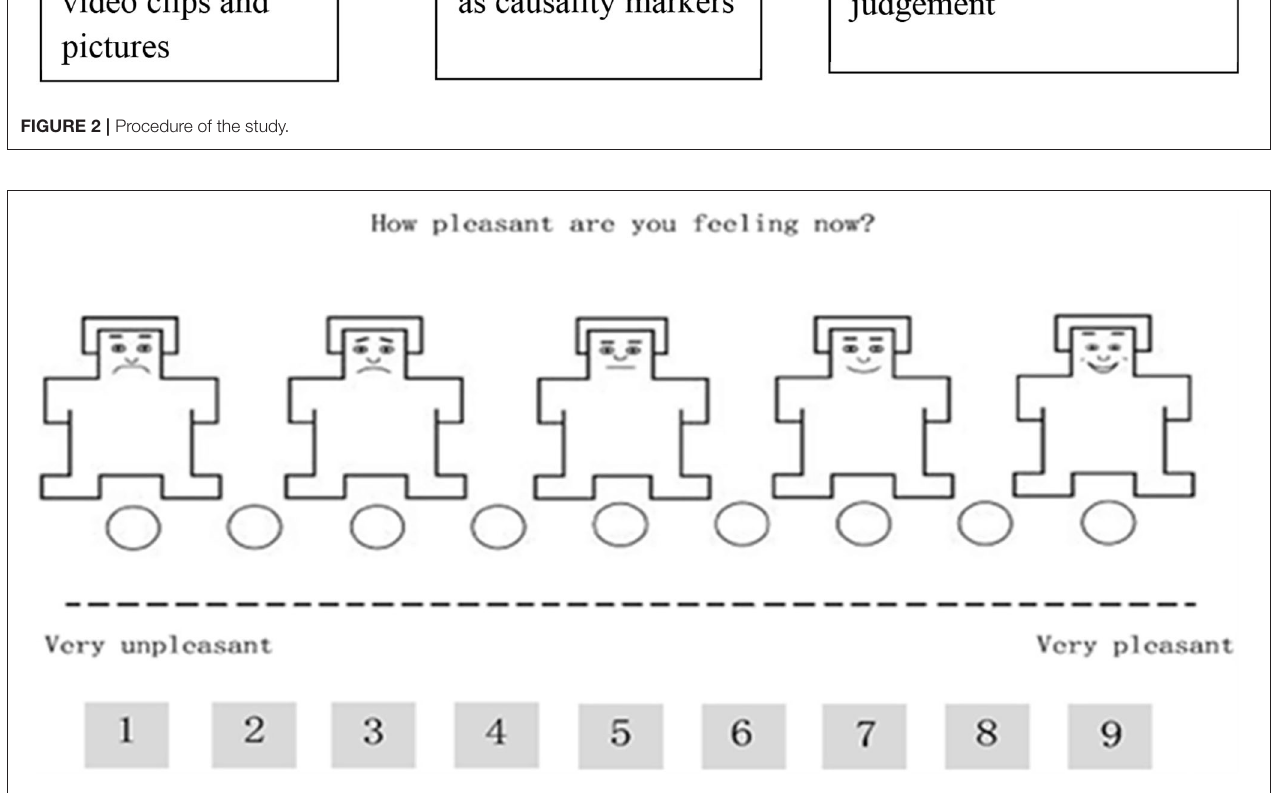
FIGURE 3 | SAM scale on the 9-point scale to evaluate the emotional valence.